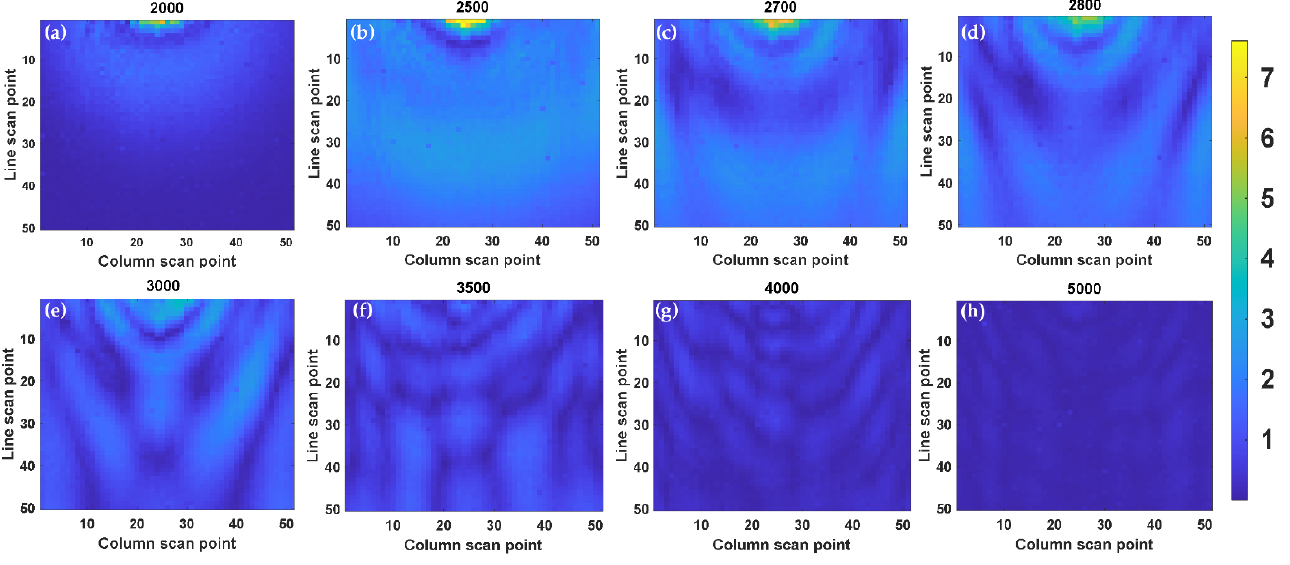
Figure 3. Experimental results of the propagation of UGWs in the battery. (The sampling length of the time domain signal is 10,000 points, ( a – h ) correspond to the 2000th, 2500th, 2700th, 2800th, 3000th, 3500th, 4000th and 5000th sampling moments, respectively).